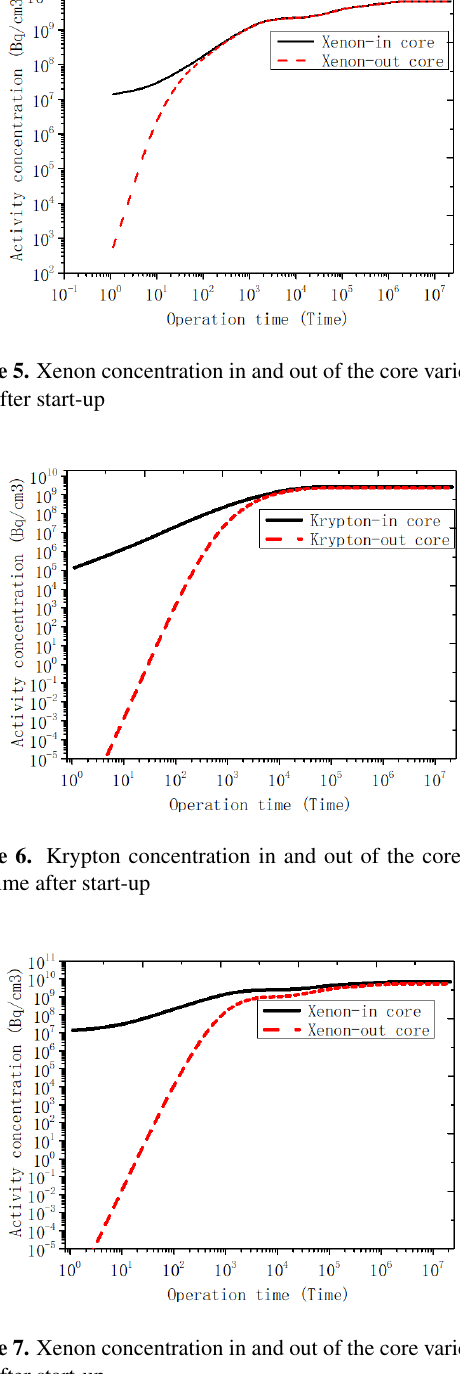
Figure 7. Xenon concentration in and out of the core varies with time after